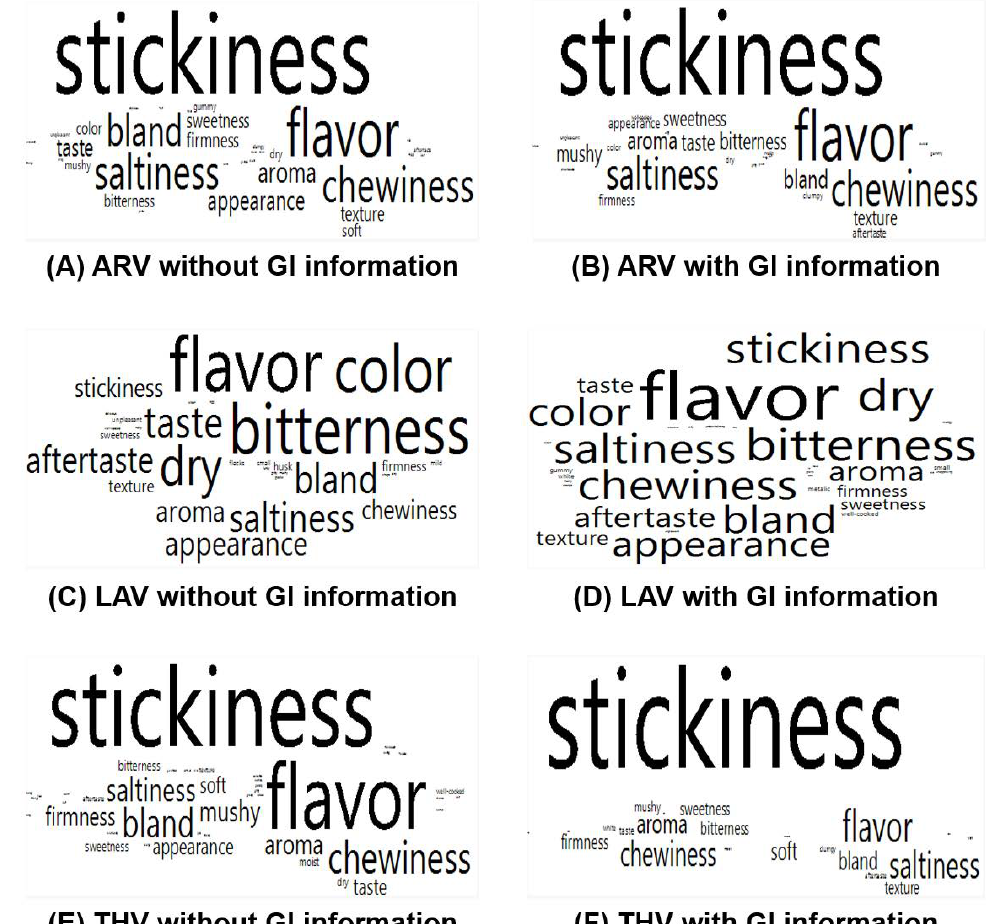
Figure 5. Geographical indication (GI) information-induced variations in the relative percentages of negative terms for each of the three cooked aromatic rice samples: ( A , B ) ARoma 17 (ARV), ( C , D ) Jazzman-2 (LAV), and ( E , F ) Jasmine from Thailand (THV). The size of a term in the visualization represents the number of responses reported as what participants liked for each of the three cooked aromatic rice sample. The layout of each term has no specific meaning. A list of terms reported by at least 10 participants for each cooked aromatic rice sample is shown in Table S5.